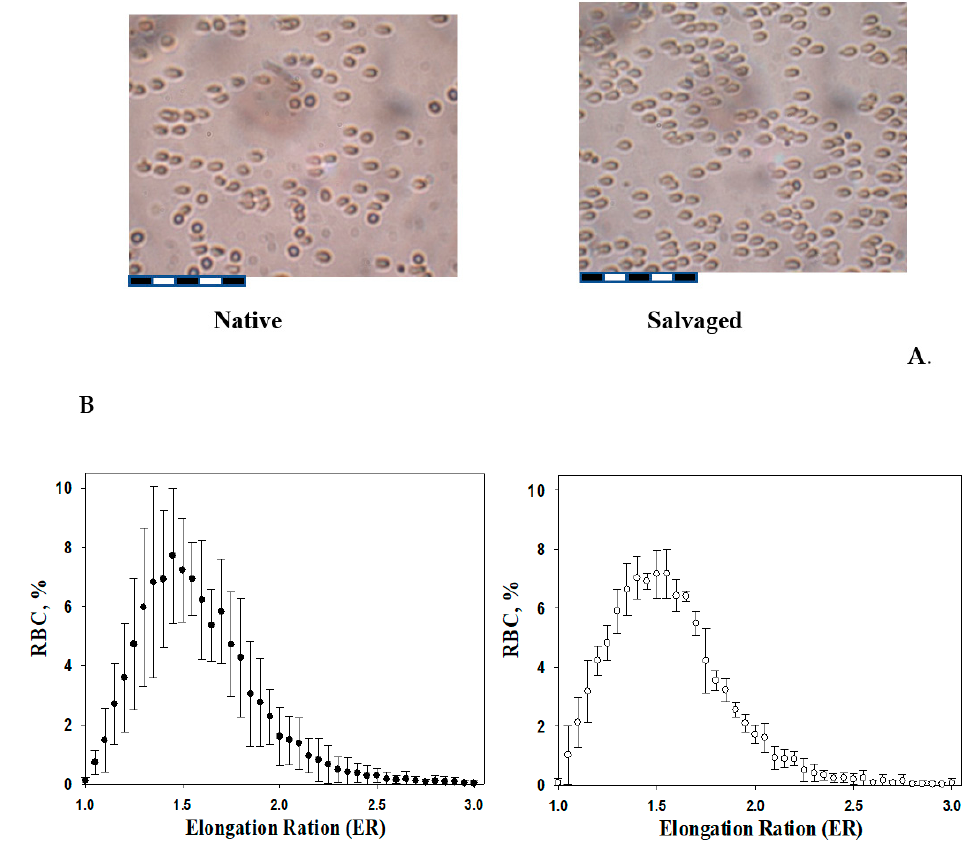
Figure 6. Deformability of freshly collected and salved RBCs. ( A ). Representative images of deformed RBCs for freshly collected and salved RBCs. Scale bars are 50 µ m (5 µ m × 10 µ m). ( B ). Generalized Elongation Ratio (ER) distribution curves calculated for five paired samples collected before (left panel) and after (right panel) salvage.